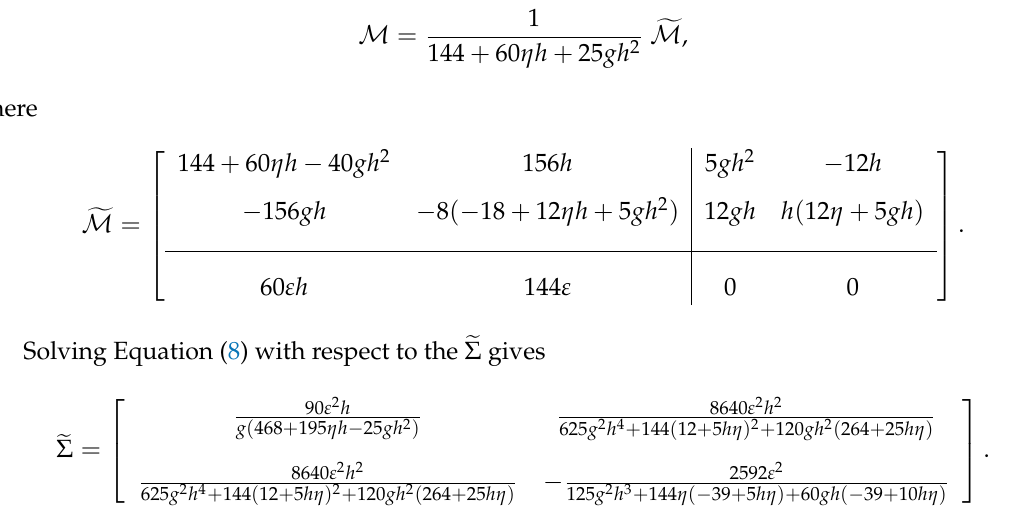
Figure 1. Graphs of | (cid:101) σ 2 line) over η , for the Euler-Maruyama method applied to Equation (2), with g = 1, h = 10 − 2 , ε =